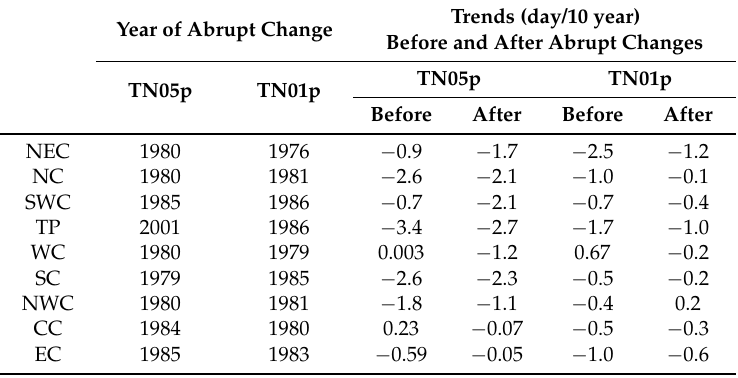
Table 4. Years of abrupt changes and trends before and after abrupt changes in TN05p and TN01p. Trends (day/10 year) Year of Abrupt Change Before and After Abrupt Changes TN05p TN01p TN05p TN01p Before After Before